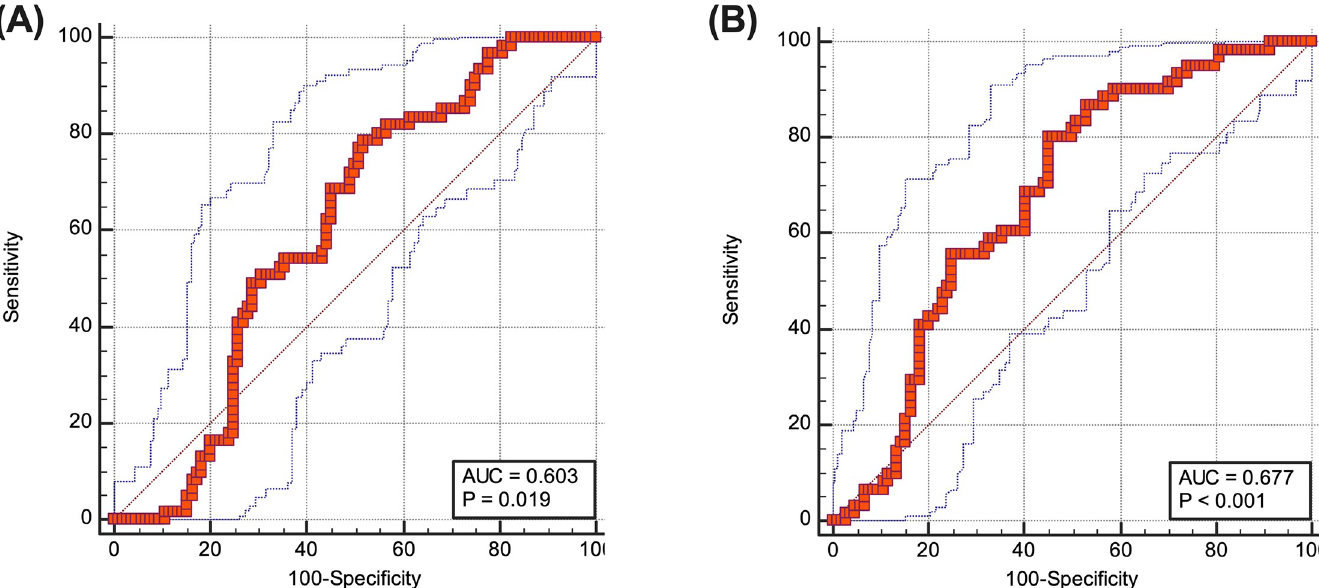
Fig 7. Receiver operating characteristics curve for prediction of skeletal muscle mass at L3 (A) and skeletal muscle index at L3 (B) using paravertebral muscle area at C3 in head and neck cancer patients.